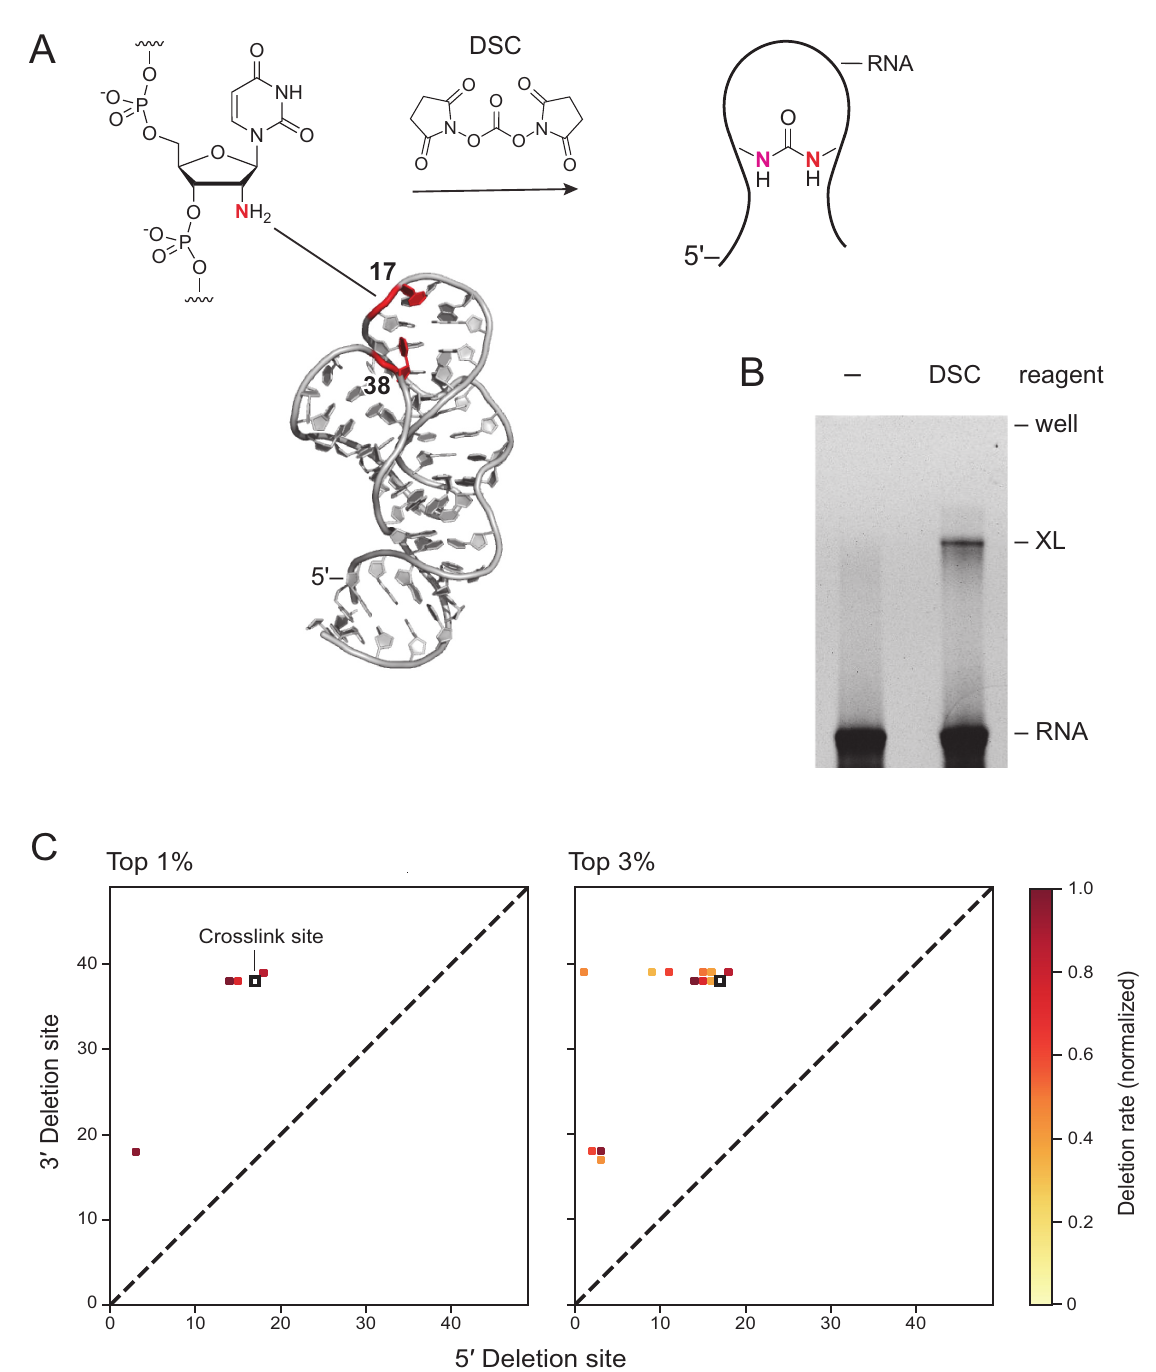
Fig 6. ShapeJumper detects deletions from known crosslink site. ( A ) Structure of the CR4/5 domain of the medaka telomerase RNA (PDB: 2mhi). 2’-amine functionalized nucleotides are red. A defined crosslinked was introduced by treatment with the amine-selective crosslinker DSC. ( B ) Visualization of crosslinking by denaturing gel electrophoresis. Experiments were performed without (–) and with DSC. Gel lanes have been straightened for clarity, but are otherwise unmanipulated. ( C ) Contact maps for most frequent 1% and 3% of deletions as detected by SHAPE-JuMP and ShapeJumper analysis of crosslink-containing RNA. Black box represents the known crosslink site; squares show deletions found by ShapeJumper. Detection rates (see scale) are normalized by the highest observed deletion rate.